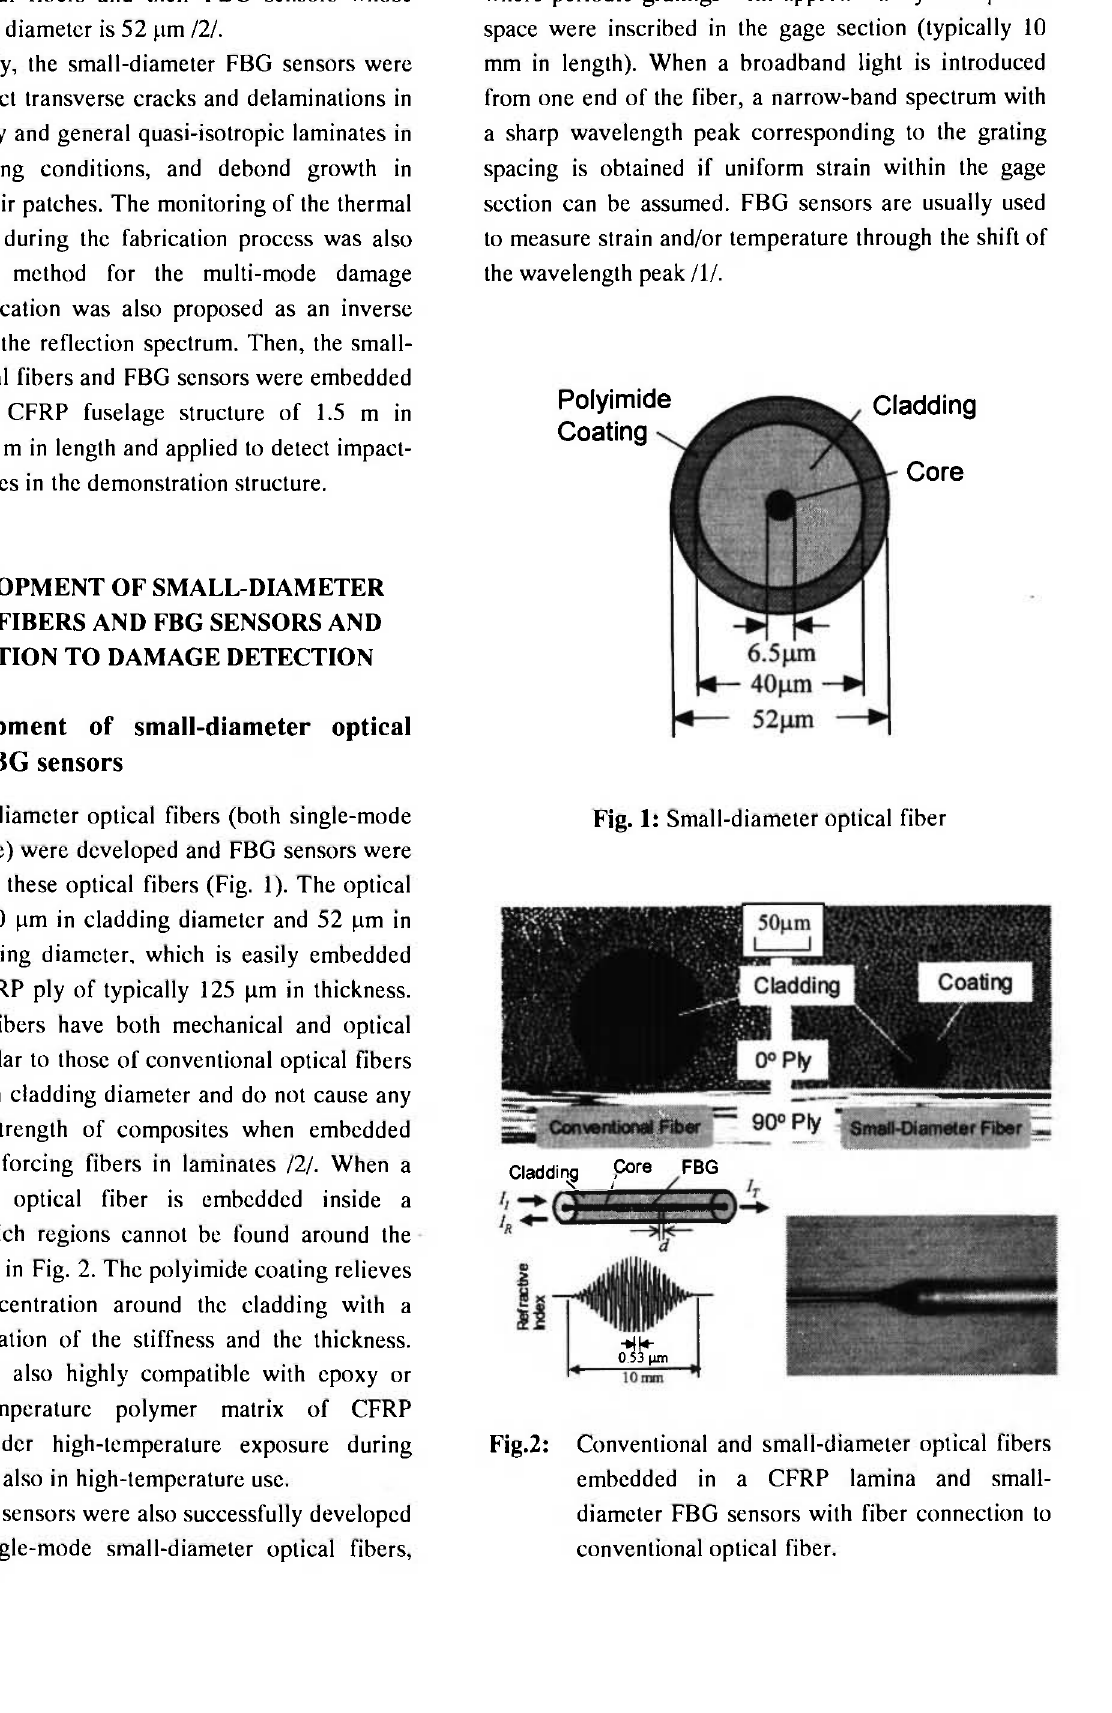
Fig.2: Conventional and small-diameter optical fibers embedded lamina and small- diameter FBG sensors with fiber connection to conventional optical